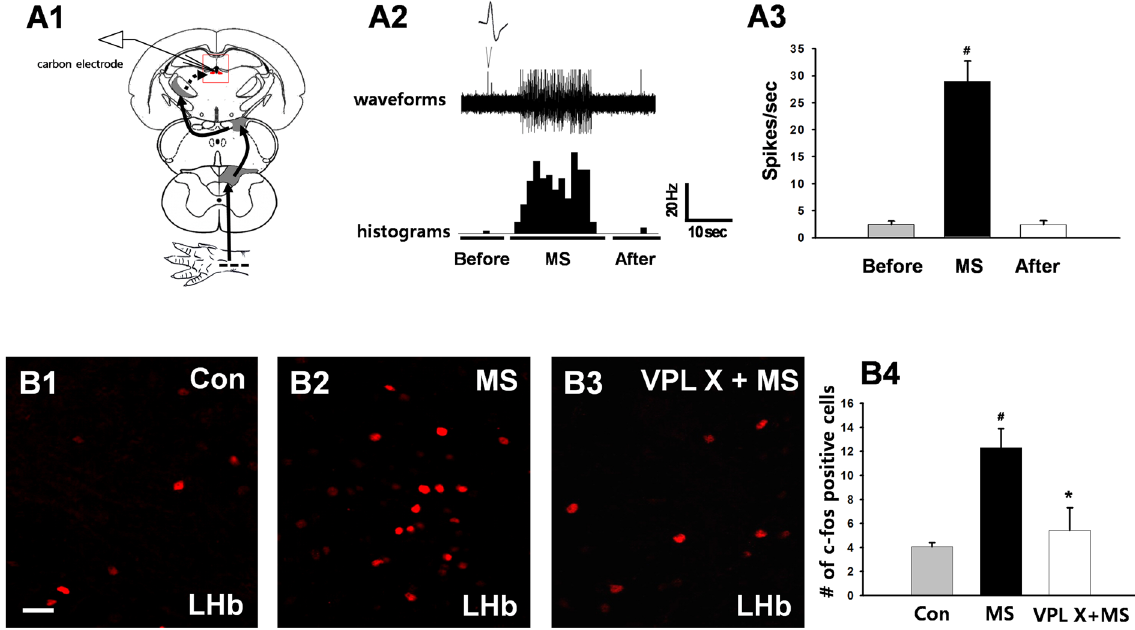
Figure 5. The role of the VPL in the neural activation of LHb following ulnar MS. ( A ) Extracellular single-unit recordings in the LHb during ulnar MS. Representative waveforms (A1) and peri-stimulus time histograms (A2). Single-unit activities of LHb neurons were markedly evoked during ulnar MS ( n = 7) (A2–3). # p < 0.05 vs. Before. ( B ) Ulnar stimulation (MS, n = 5; B2, B4) significantly increased the numbers of c-fos immunopositive cells, compared to control (Con, n = 5; B1, B4), which was prevented in the rats injected with ibotenic acid into VPL (VPL X, n = 5; B3–4). # p < 0.05, Con vs. MS; * p < 0.05, MS vs. VPL X + MS. Bar = 20 µ